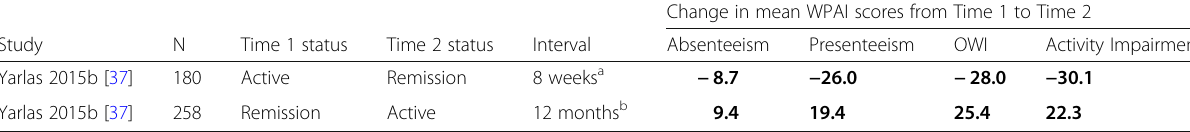
Table 6 Changes in WPAI scores over time as a function of change in UC disease activity status